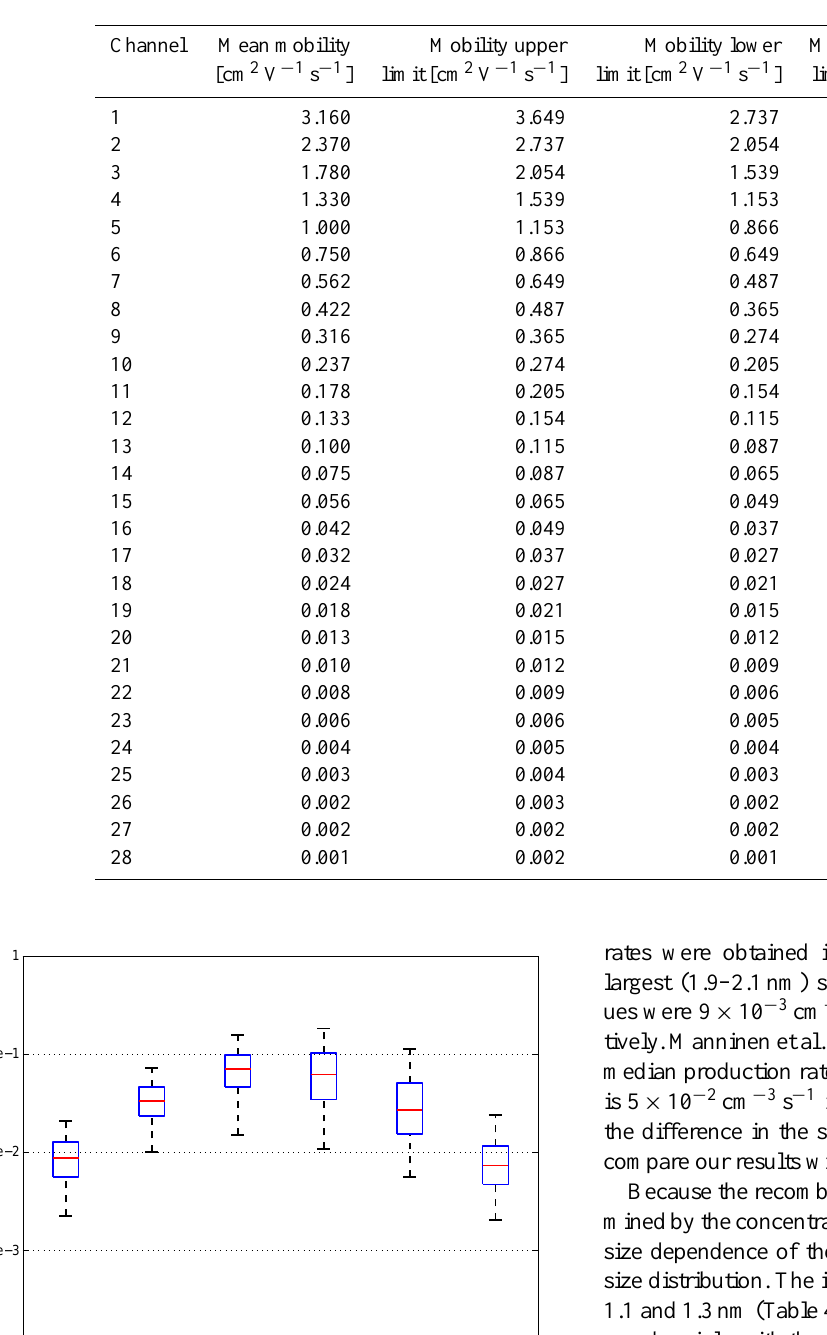
Table 2. The mobility and mass ranges of the NAIS channels.